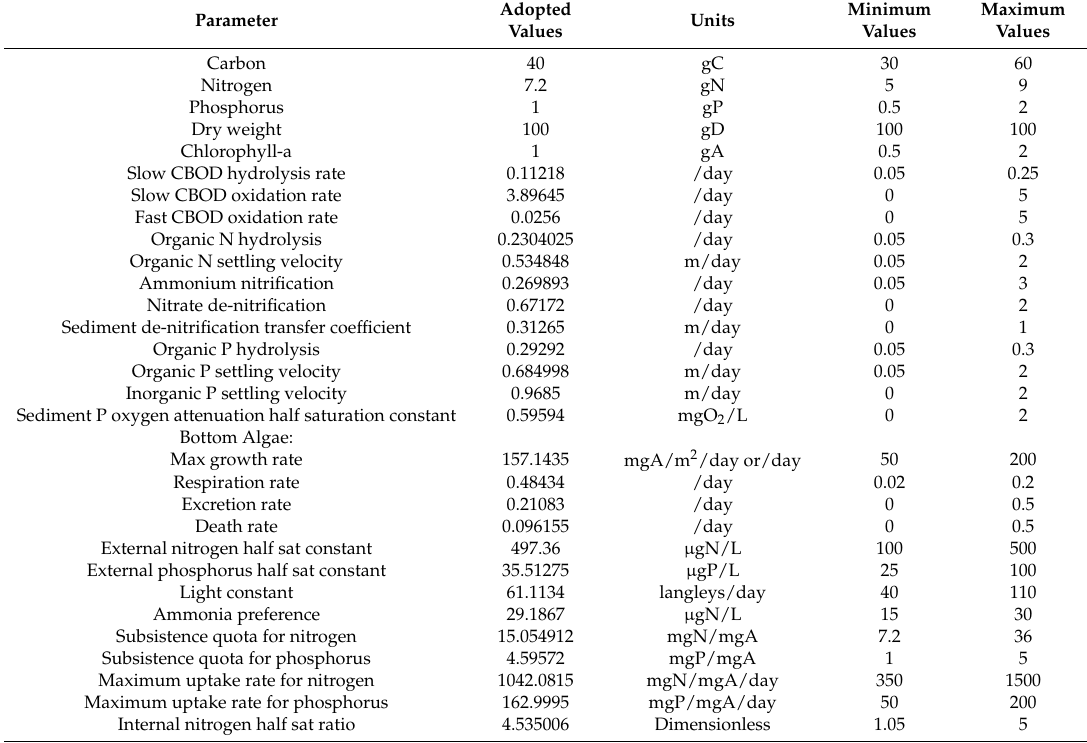
Table 3. System parameters in the Osan